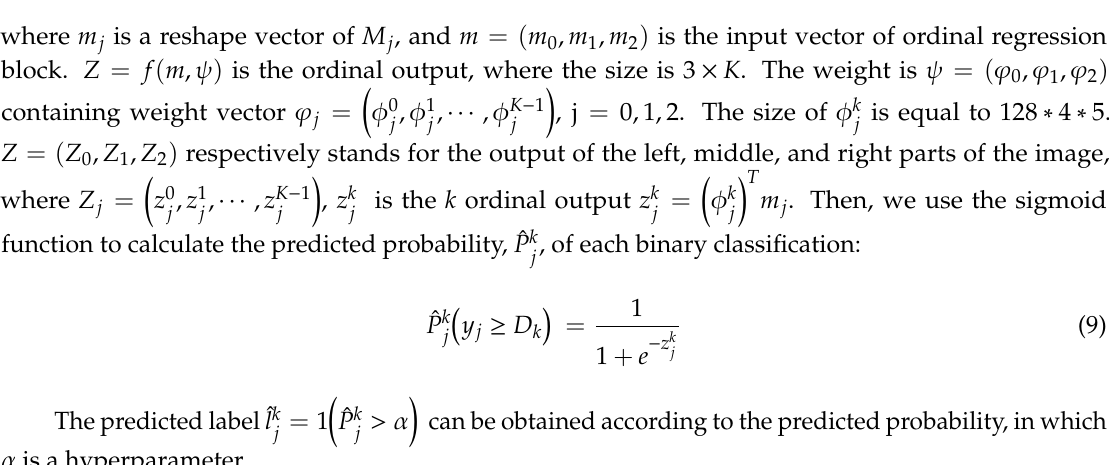
Figure 4. Detail blocks. ( a ) Division. ( b ) Ordinal regression